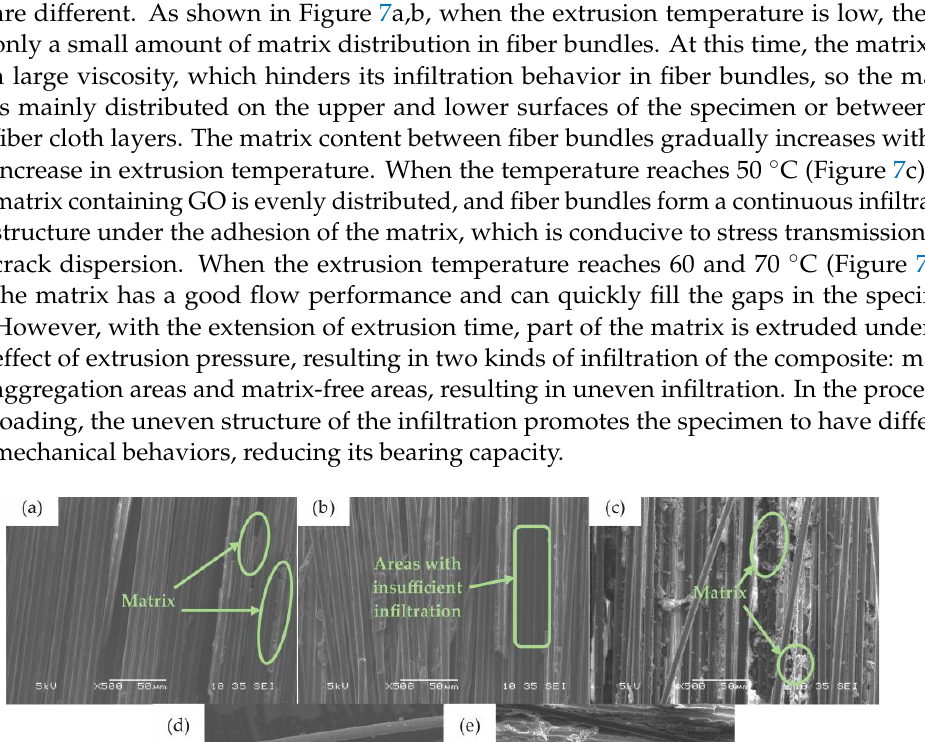
Figure 7. Infiltration structure of GO-CF/EP composites at different extrusion temperatures: ( a ) 30 °C, ( b ) 40 °C, ( c ) 50 °C, ( d ) 60 °C, ( e ) 70 °C.